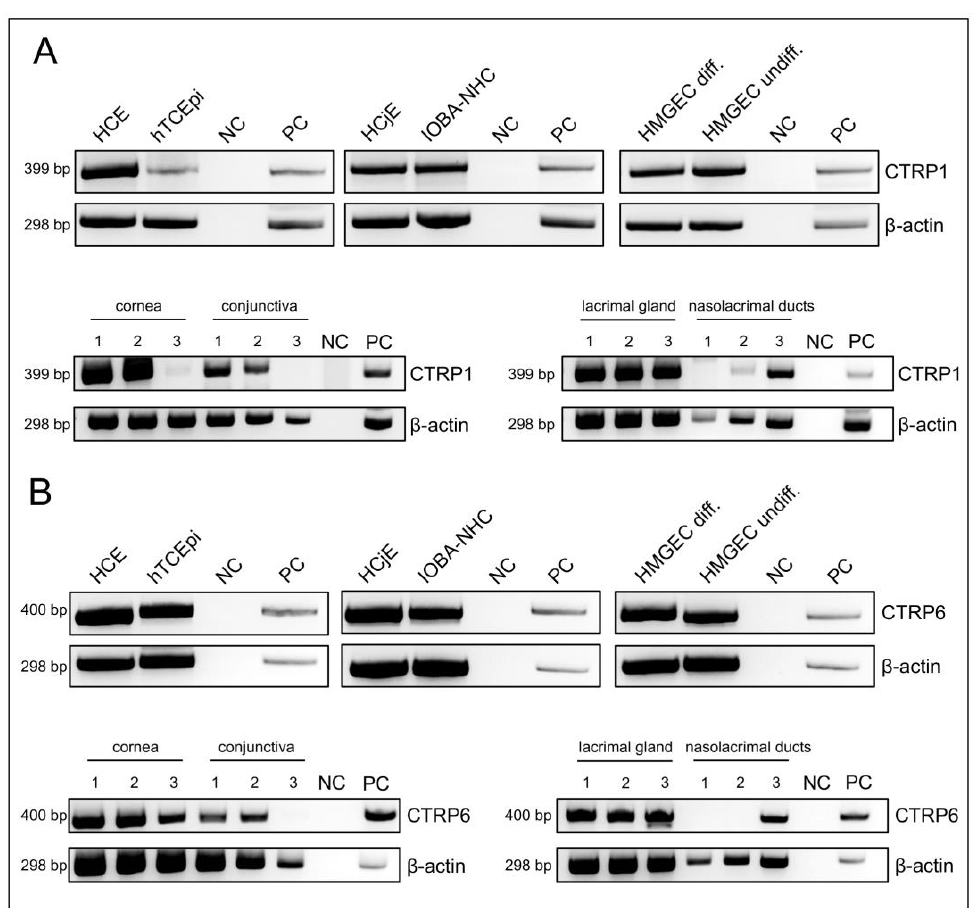
Figure 1. CTRP1 and CTRP6 gene expression in human tissues and cell lines by RT-PCR. ( A ) Gene expression of CTRP1. ( B ) Gene expression of CTRP6. The gene expression is shown by the black bands. Expression of β -actin confirms the presence of tested cDNA. Human corneal epithelial cells (HCE), telomerase-immortalized human corneal epithelial cells (hTCEpi), human con- junctival epithelial cells (HCjE), IOBA-normal human conjunctiva (IOBA-NHC), human meibomian gland epithelial cells (HMGEC; differentiated and undifferentiated). Positive control (PC) is liver for CTRP1 and placenta for CTRP6. Negative control (NC) contains no template cDNA. Pictures are representative for at least three individual experiments for each tissue and cell